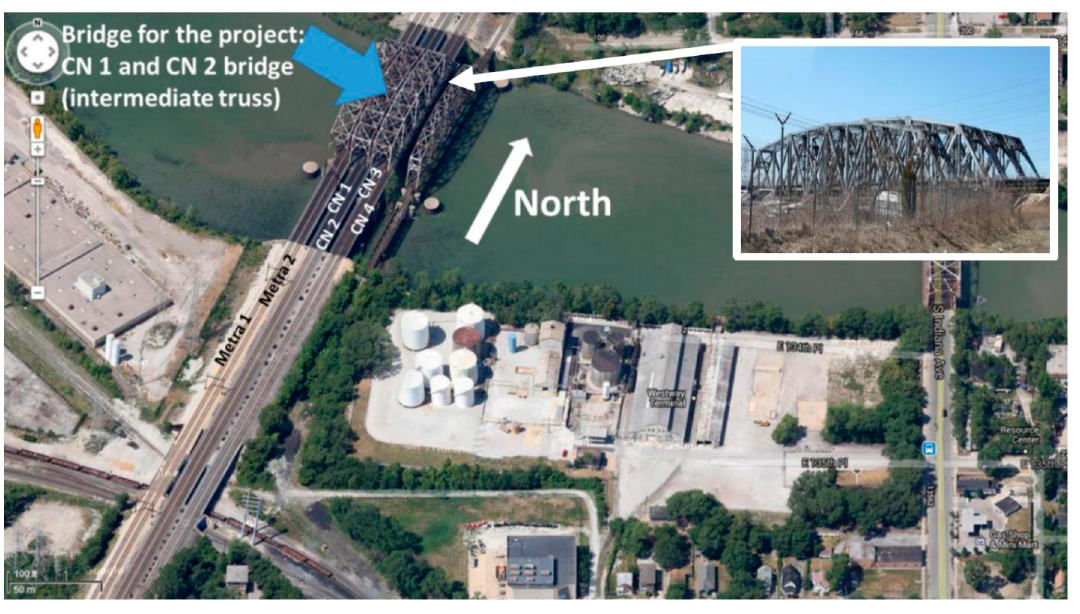
Figure 2. Test bridge (i.e., Calumet Bridge) marked as CN1 and CN2 [32,33].